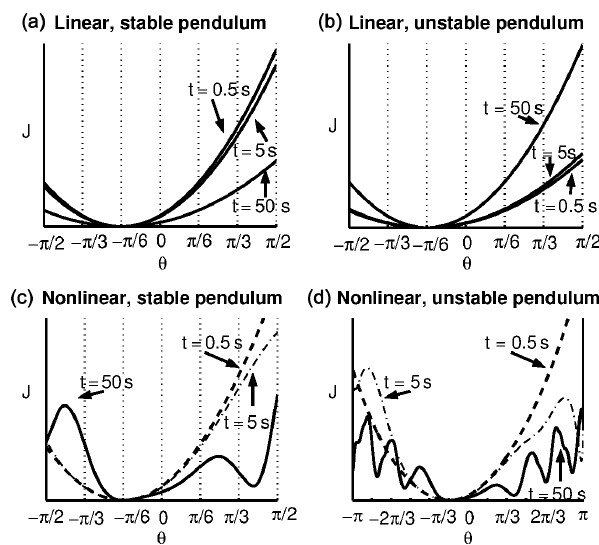
Figure 9. Cost function with respect to the initial pendulum an- gle. A synthetic observation was made from a model run with ini- tial angle, θ =− π/ 6. The time between the initial state and the cost-function evaluation is 0.5, 5, or 50s. (a) Linear, stable pendu- lum. (b) Linear, unstable pendulum. (c) Nonlinear, stable pendulum. (d) Nonlinear, unstable pendulum. Notice the wider scale for θ in the lower, right panel. The pendulum’s dynamical regimes are fur- ther explained in the text. Reproduced with permission from Gebbie